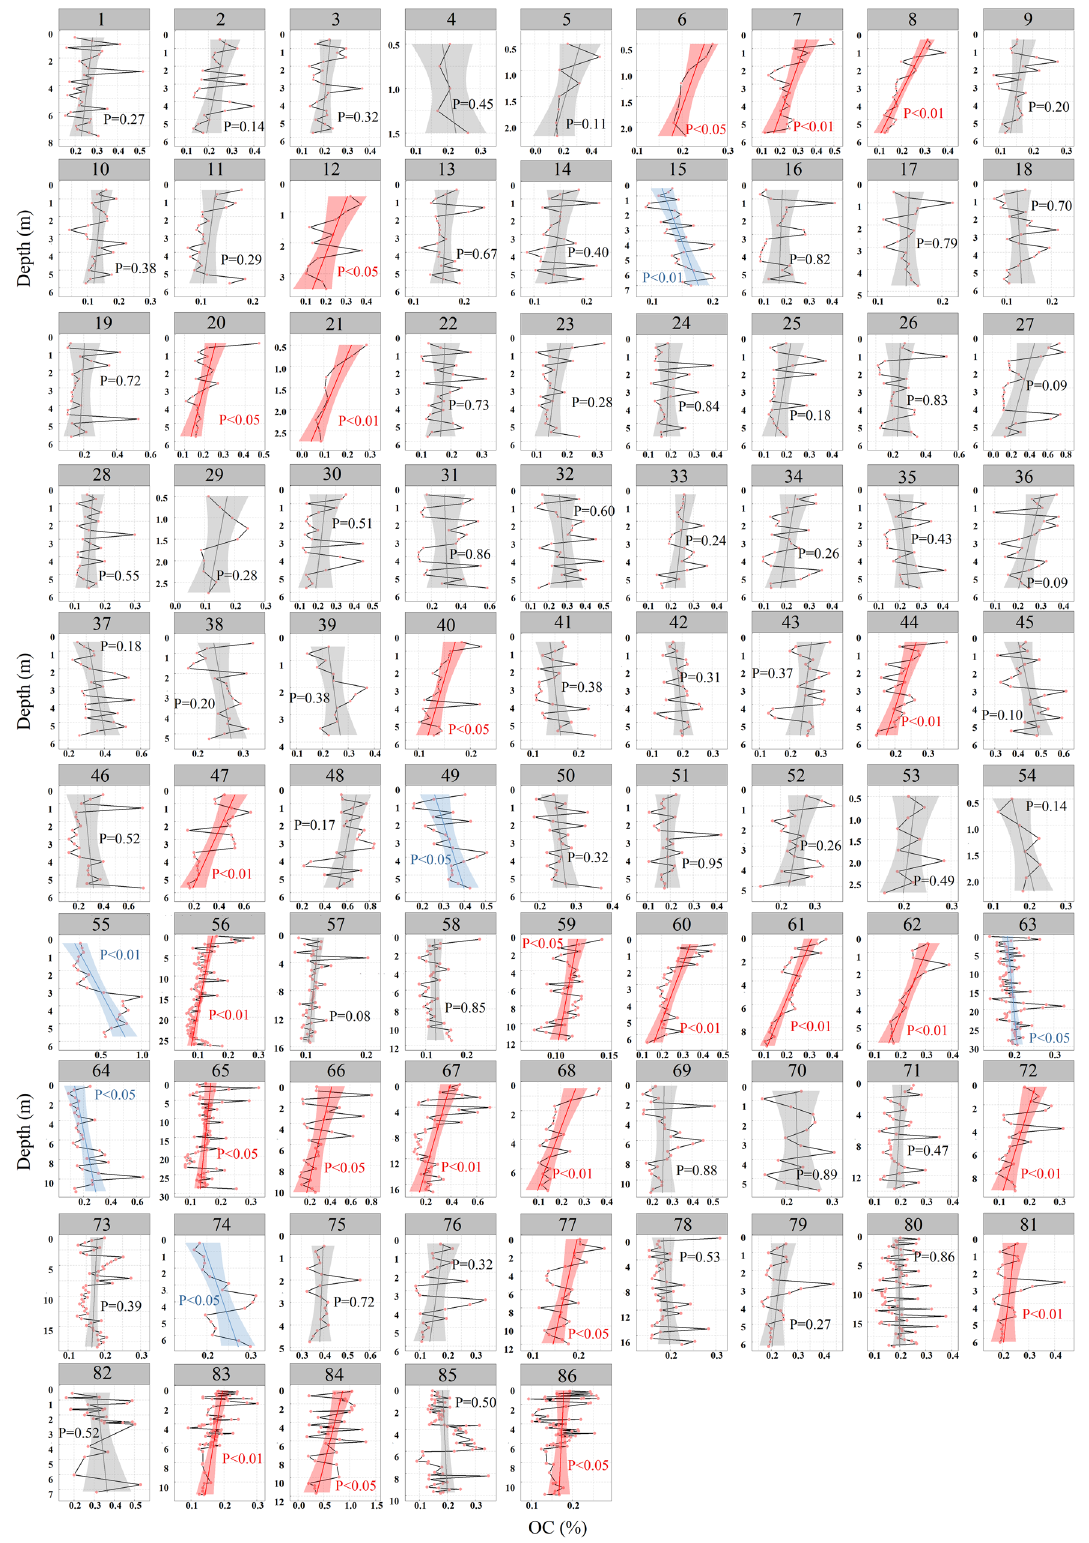
Fig. 7 Vertical distribution of OC concentration in 86 sediment cores. The shade areas represent 95% con fi dence interval and the blue and red mark represents a signi fi cant upward or downward trend, respectively ( p <